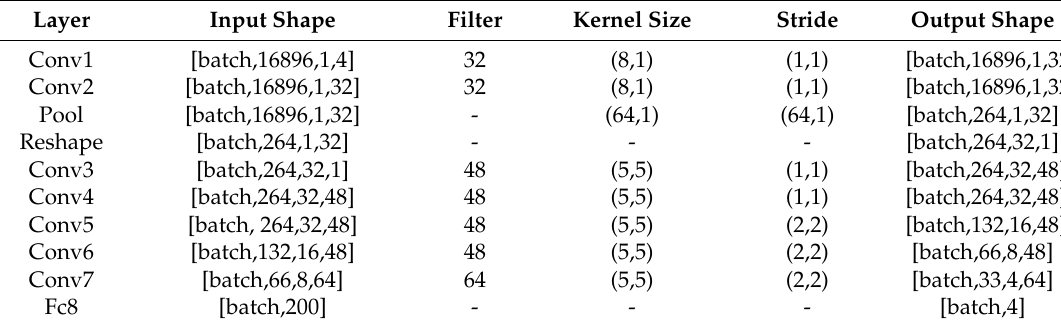
Table 1. Parameter of the end-to-end stacked